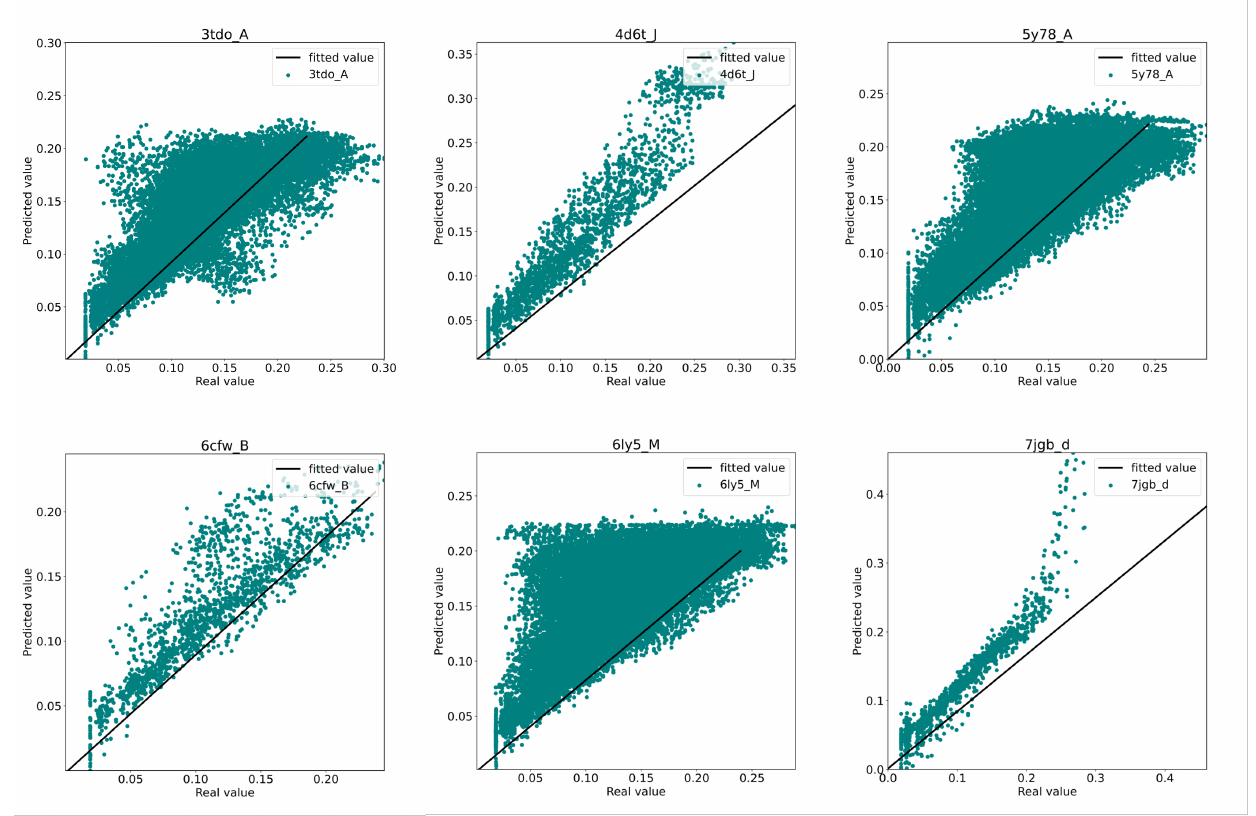
Figure 4. The relationship between the predicted value obtained by TMP-SurResD and the surface residue distance value calculated by coordinates. The black line indicates the fit between the true value and the predicted value; the green scatter demonstrates that the predicted value is larger than the true value.